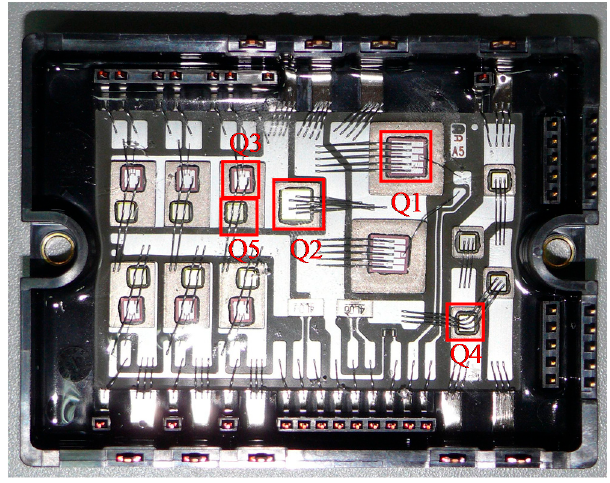
Figure 1. Power chipset.